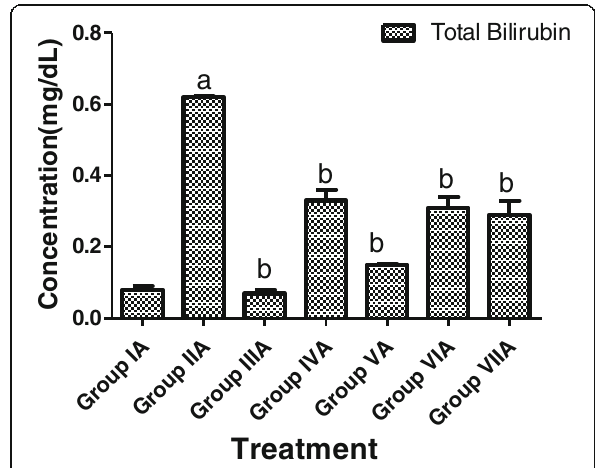
Fig. 3 Effect of methanol extract of T. conophorum seeds on Total bilirubin levels in CCl 4 induced hepatotoxicity in rats after 24 h of intoxication. Values are Mean±SEM, n =5 rats in each group. p <0.05, a as compared with the normal control group; b as compared with the CCl 4 only (group IIA). CCl 4 , Carbon tetrachloride. Group IA (control) received distilled water and olive oil (i.p), group IIA rats were intoxicated with CCl 4 in olive oil (600 mg/kg, i.p.) only on the 8th day, while groups IIIA, IVA and VA were given 100 mg/kg of silymarin, 250 mg/kg and 500 mg/kg of methanol extract, respectively for 7 days, thereafter intoxicated with CCl 4 on the 8th day. Groups VIA and VIIA were intoxicated with CCl 4 on the 8th day and administered 250 mg/ kg and 500 mg/kg of methanol extract of T. conophorum seeds at 1 h, 6 h, 12 h, 18 h and 24 h. Fasting blood samples were collected after the last administration of the extract at 24 h of intoxication with CCl 4